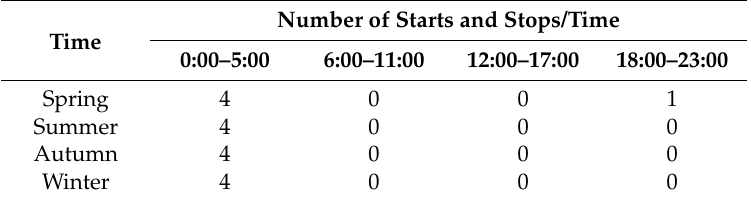
Table 8. Unit start and stop